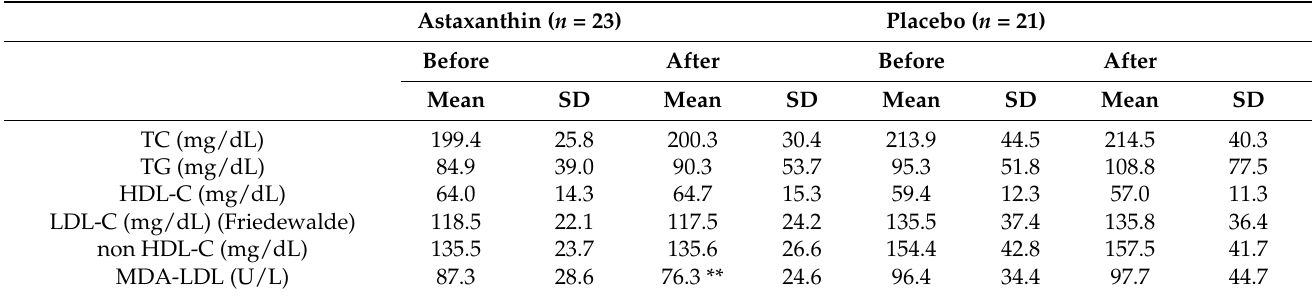
Table 2. Changes in lipids profile after supplementation with 12 mg ASTX for 12